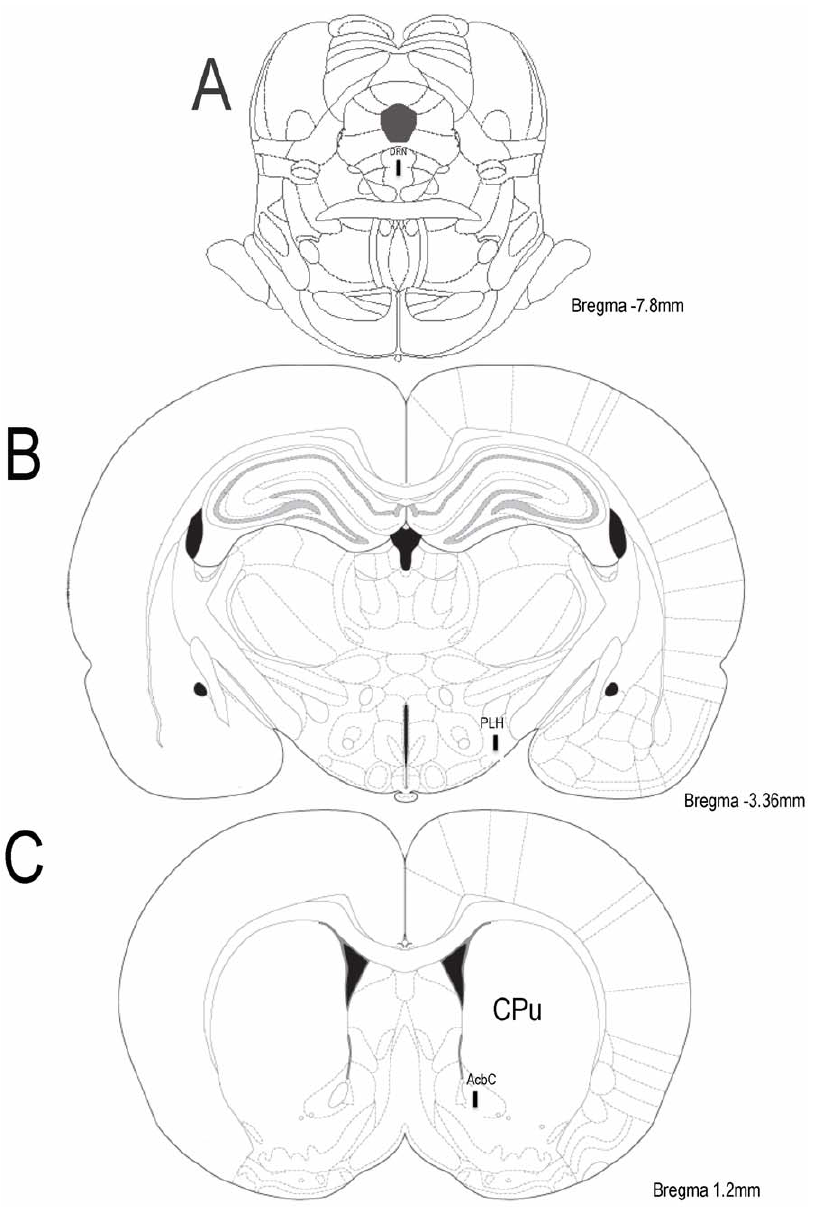
Figure 1. Schematic drawings from rat brain atlas [ 23 ] showing a vertical black bar that represents the localization of the cannulae placed at DRN (Panel A), LH (Panel B) or the microdialysis probe placed into AcbC (Panel C). Abbreviations: AcbC, nucleus accumbens, core; CPU, caudate putamen; DRN, dorsal raphe nucleus, dorsal part; PLH, peduncular part of lateral hypothalamus. doi:10.1371/journal.pone.0020766.g001 PLoS ONE |